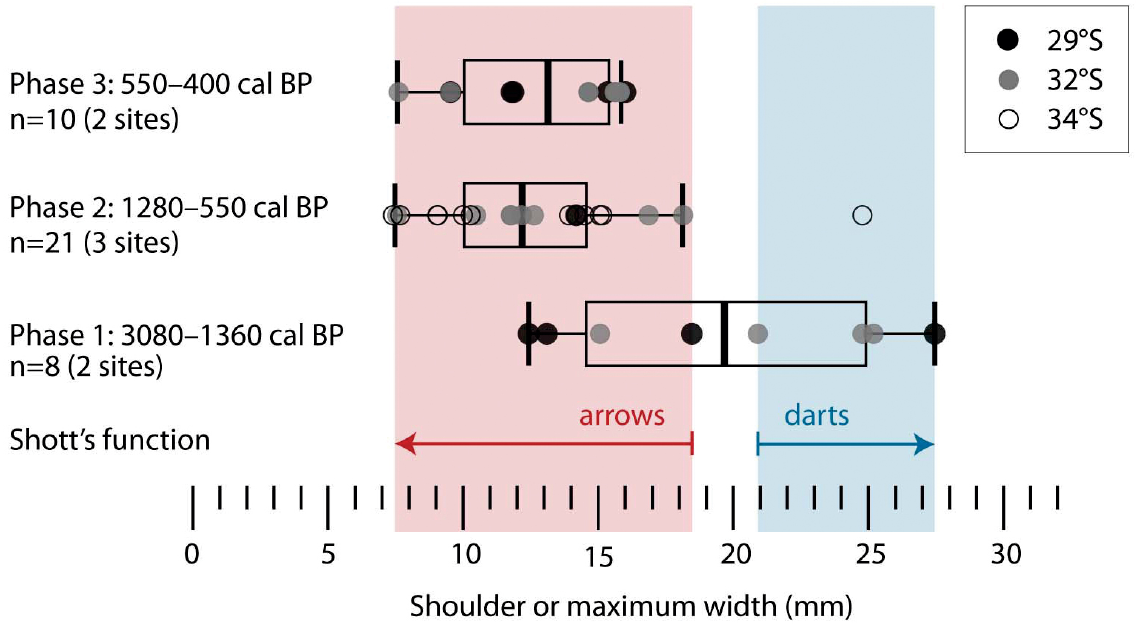
Figure 2. Measurements and Shott’s function for projectile